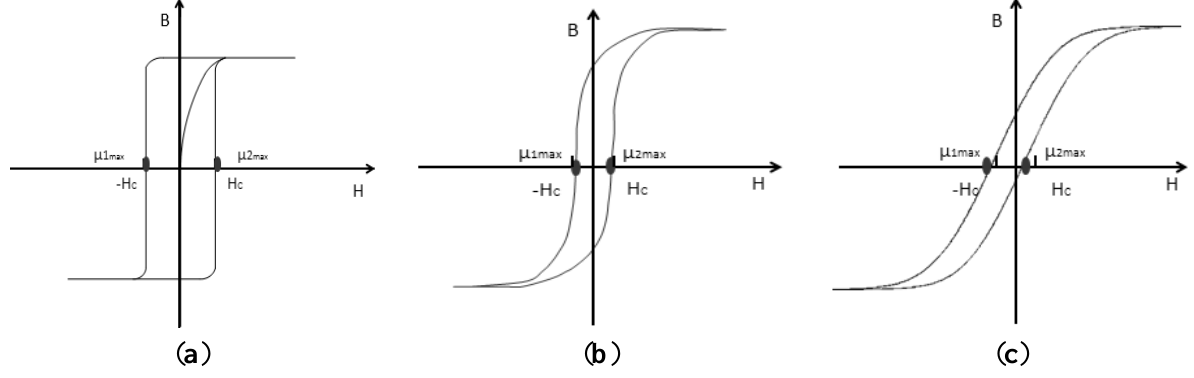
Figure 2. ( a ) The ideal hysteresis loop model. ( b ) The static hysteresis loop model. ( c ) The actual dynamic hysteresis loop